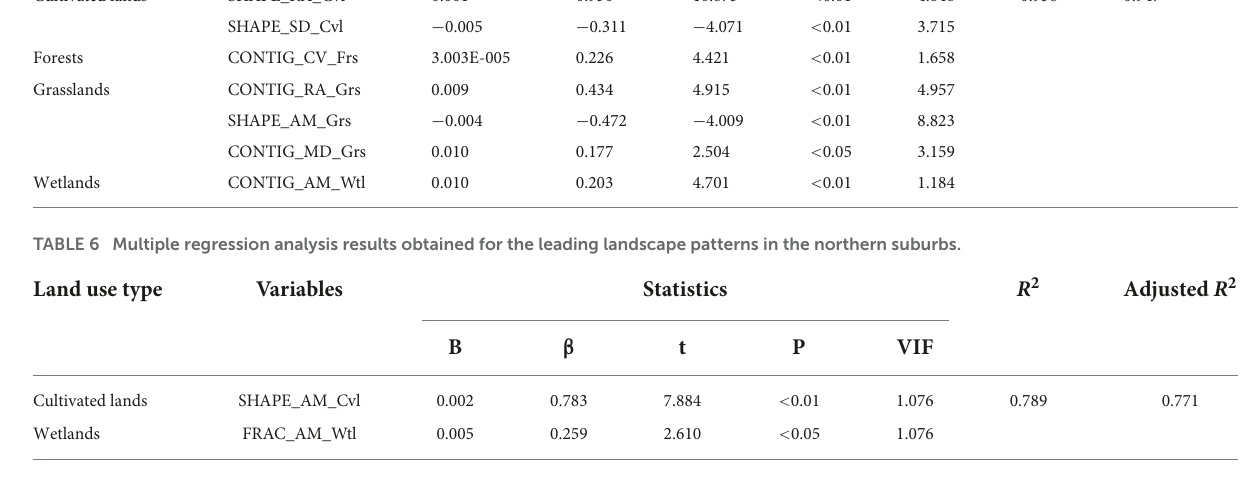
TABLE 7 Multiple regression analysis results obtained for the leading landscape patterns in the southern